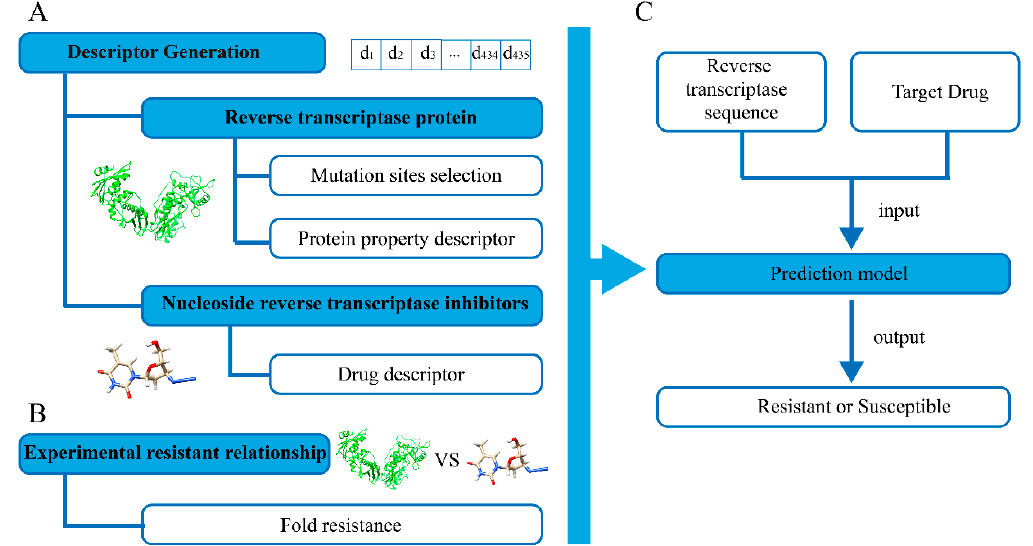
Figure 1. Workflow of drug resistance prediction model for HIV-1 reverse transcriptase. ( A ) The 435-bit descriptors describing the physic-chemical and structural properties of the transcriptase proteins and NRTIs. ( B ) The experimental assay was collected to reflect the resistant or susceptible relationship between transcriptase proteins and NRTIs. ( C ) Machine learning approaches were introduced based on the descriptors and the experimental relationship to generate the PCM